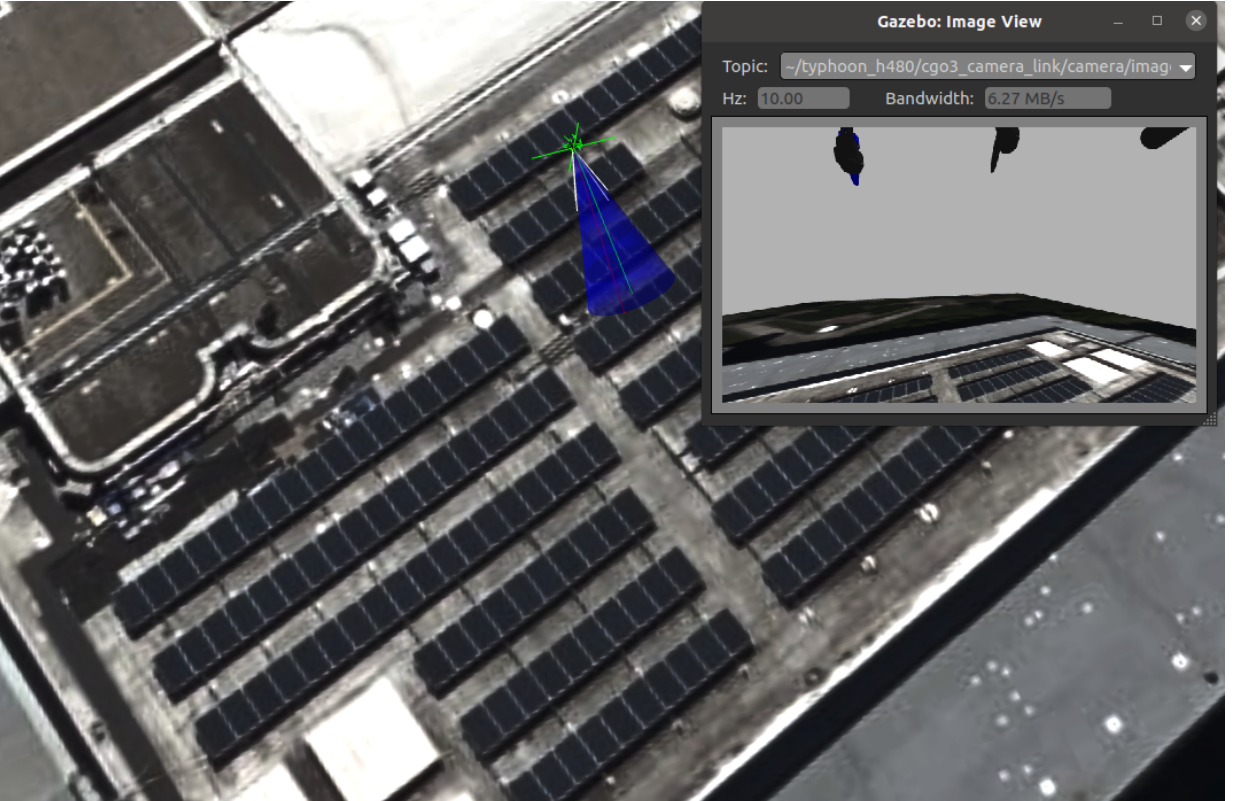
Figure 5. UAV over A PV plant, simulated in